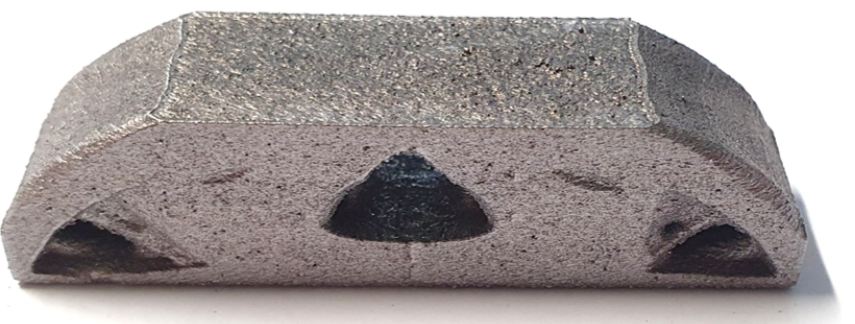
Figure 27. Design proposals of developed topology optimization method for optimization case 2 manufactured in the PBF-LB process.